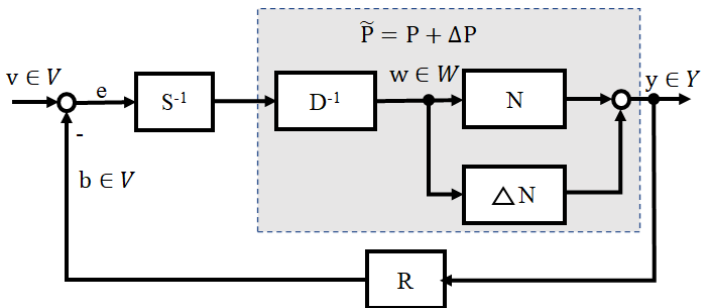
Figure 3. Nonlinear operator-based feedback control system with